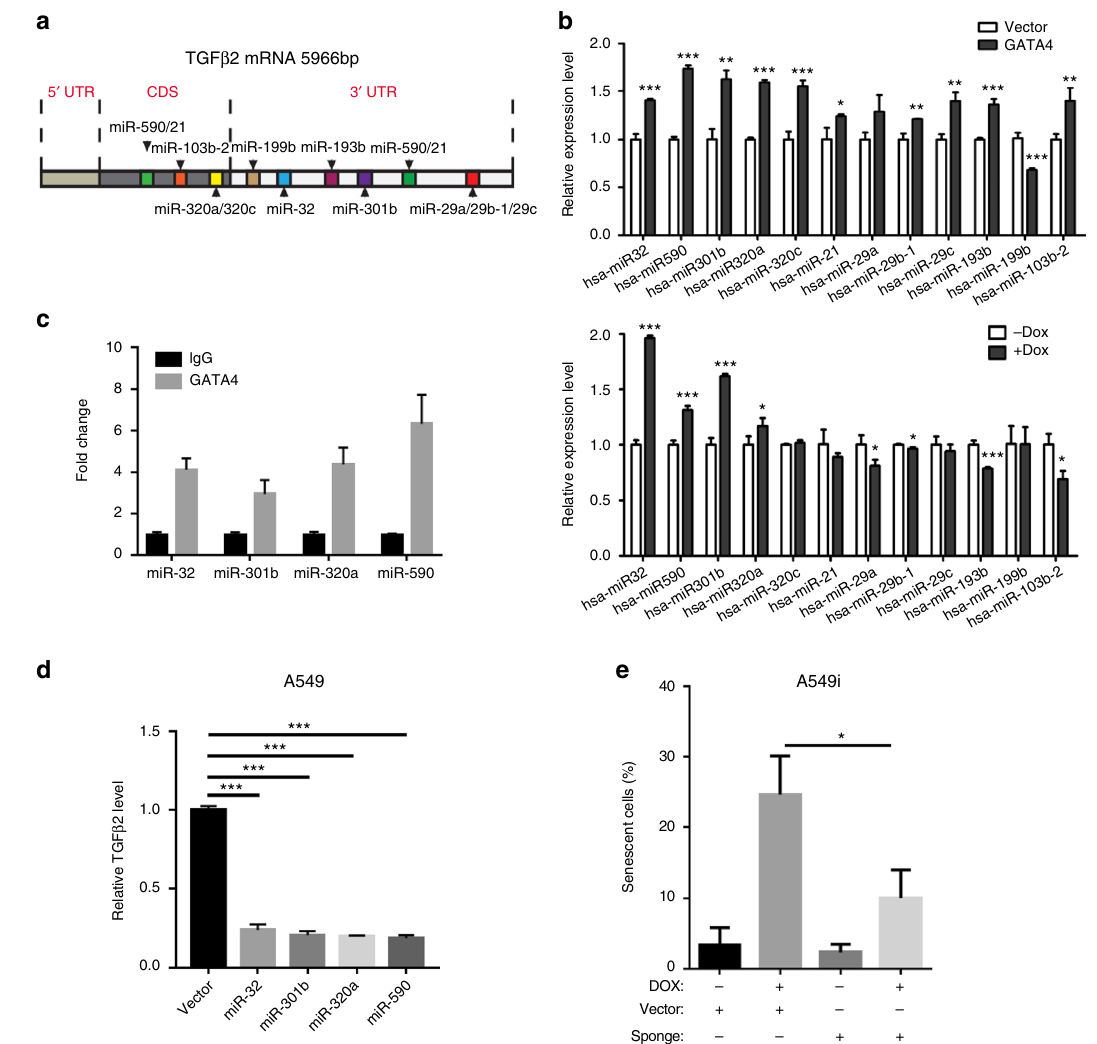
Fig. 5 GATA4 downregulates the TGFB2 mRNA level through multiple miRNAs. a Schematics of targeting sites on TGFB2 mRNA recognized by 14 miRNAs. b Relative expression level of miRNAs before and after GATA4 overexpression in A549i (through 2 μ g/mL of Dox treatment) and A549 cells (through lentivirus infection) ( n = 3 per group). c qPCR analysis of promoter fragment of designated gene from DNA samples prepared from control IgG or anti- FLAG (for pulldown GATA4) DNA samples. Quantity of GATA4 bond DNA was normalized by the value in control IgG-treated samples ( n = 3 per group). d TGFB2 mRNA level in A549 cells overexpressing miR-32, miR-301b, miR-320A, or miR-590, respectively ( n = 3 per group). e β -Galactosidase signal in GATA4 overexpressing A549 cells in the absence or presence of microRNA sponge ( n = 3 per group). Bars are represented as mean ± SEM of the indicated number ( n ) of repeats. *P < 0.05, **P < 0.01, and ***P < 0.001 by Student ’ s t GATA4-TGF- β 2-Wnt-7b signaling axis is clinically relevant . Our above data have shown that GATA4 expression down- regulated TGFB2 and the ensuing downstream WNT7B signaling in A549 lung cancer cell line. This was con fi rmed in H460 cells (Supplementary Figure 6A). Conversely, knockdown of GATA4 expression level upregulated TGFB2 and WNT7B transcription in lung cancer cell line H226 (Fig. 6a), supporting that GATA4- TGF- β 2-Wnt-7b signaling axis is common to lung cancer cells. We also found signi fi cant negative correlation of expression level between GATA4 and TGFB2 and between GATA4 and WNT7B among non-manipulated lung cancer cell lines and normal lung epithelial cell lines (Supplementary Figure 6B).